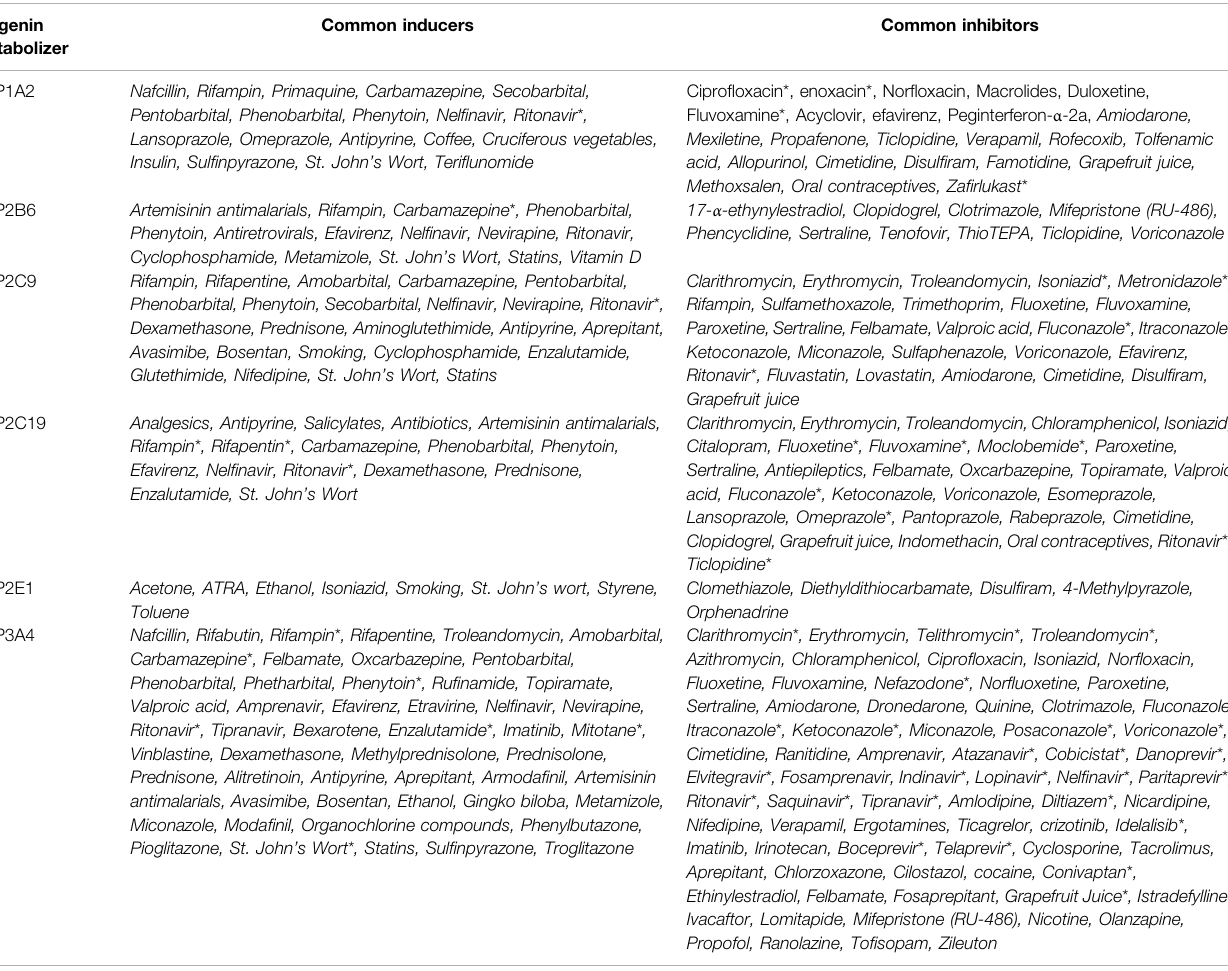
TABLE 2 | Apigenin as a substrate for phase I CYP enzymes. Based on studies looking at the induction or inhibition of luteolin production (a primary metabolite of free apigenin), data suggests that apigenin metabolism is induced by CYP1A and CYP2B enzymes, and inhibited by CYP2E1, CYP3A, CYP2B, CYP2C9 (Breinholt et al., 2002; Gradolatto et al., 2004). If these effects are corroborated in vivo , drug interactions involving medications that induce or inhibit these CYP enzymes would lead to increased apigenin metabolism (and lower plasma levels), or decreased metabolism (and increased plasma levels), respectively. Apigenin Common inducers Common metabolizer